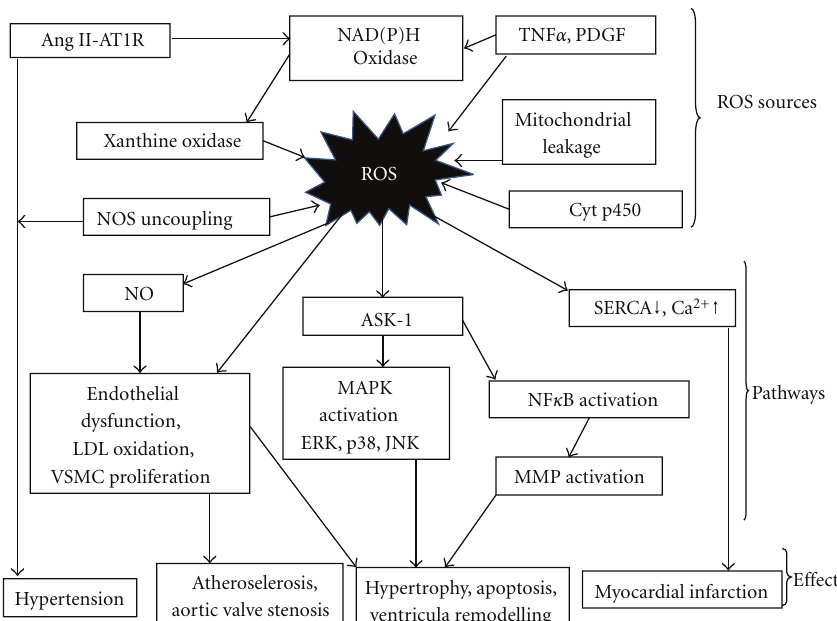
Figure 2: Potential sources of reactive oxygen species (ROS) and their e ff ects on cardiac function. Cytp450: cytochrome p450, NOS: nitric oxide synthase, PDGF: platelet-derived growth factor, TNF- α : tumor necrosis factor, ASK-I: apoptosis-regulating signal kinase, MAPK: mitogen-activated protein kinases, NF κ B: nuclear factor κ B, MMP: matrix metalloproteinase, AngII: Angiotension II, ATIR: Angiotension I receptor, and SERCA: sarcoplasmic endoplasmin reticulum calcium